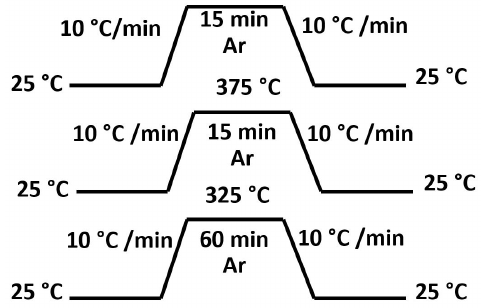
Figure 1. Diagram of different thermal treatments employed for the optimization process.